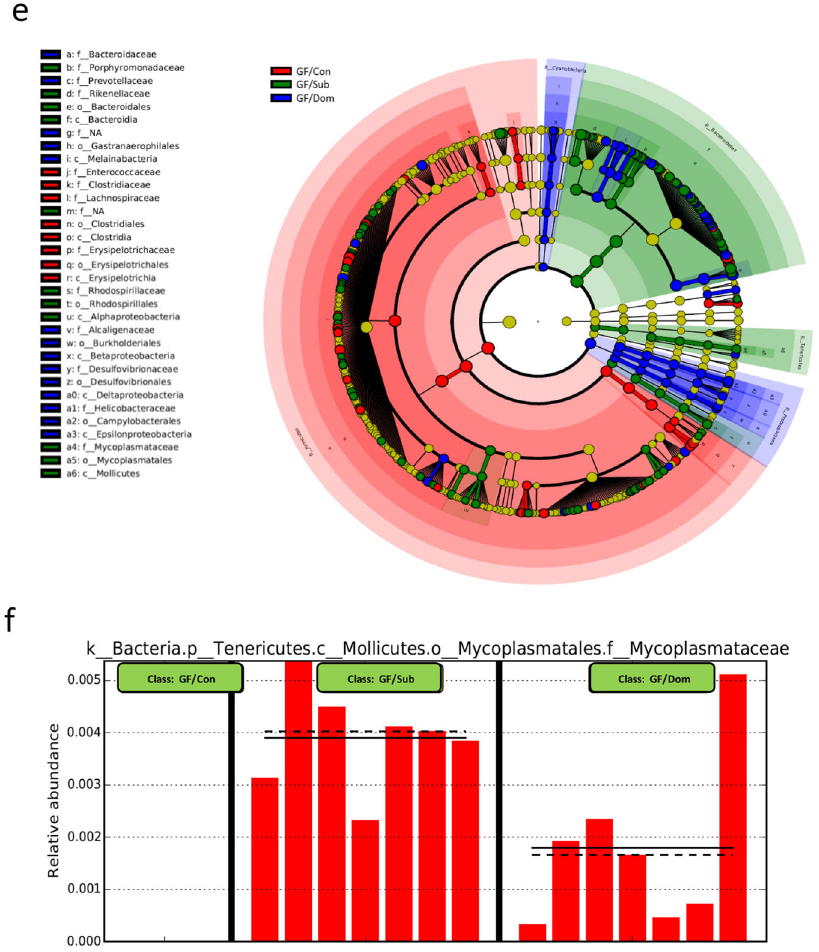
Fig. 5 Gut microbiome composition of germ-free mice after a fecal microbiota transplantation from Dom or Sub donor mice. a Experimental timeline. Germ-free (GF) mice ( n = 17) underwent a fecal microbiota transplantation (FMT) of either Dom-derived microbiota (GF/Dom, n = 7), Sub-derived microbiota (GF/Sub, n = 7), or PBS (GF/Con, n = 3). After an adaptation period, the mice underwent a series of behavioral assessments (FST; forced swim test; TCST: three-chamber Sociability test; DSR: dominant – submissive relationship test) and their adipose tissues were removed and analyzed. b Principal component analysis of the gut microbiota of GF/Con, GF/Dom, and GF/Sub mice, ( n = 17) at Day 7 post-FMT, demonstrating the clustering of the gut microbiome in each group, as well as in GF mice and in the donor mice. c A heatmap of the microbial composition of the samples at the species level, with the top 100 most variant species identi fi ed. Taxa with similar distributions are grouped together. d Relative abundance up to the genus level. An additional fi gure up to the order level (for signi fi cantly altered bacteria) is presented in Supplementary Fig. 4. e LEfSe cladogram of gut microbiota in the different mouse groups. Taxa whose distributions among different groups are signi fi cantly different ( p < 0.05 and the effect size >2). f Abundance histograms of